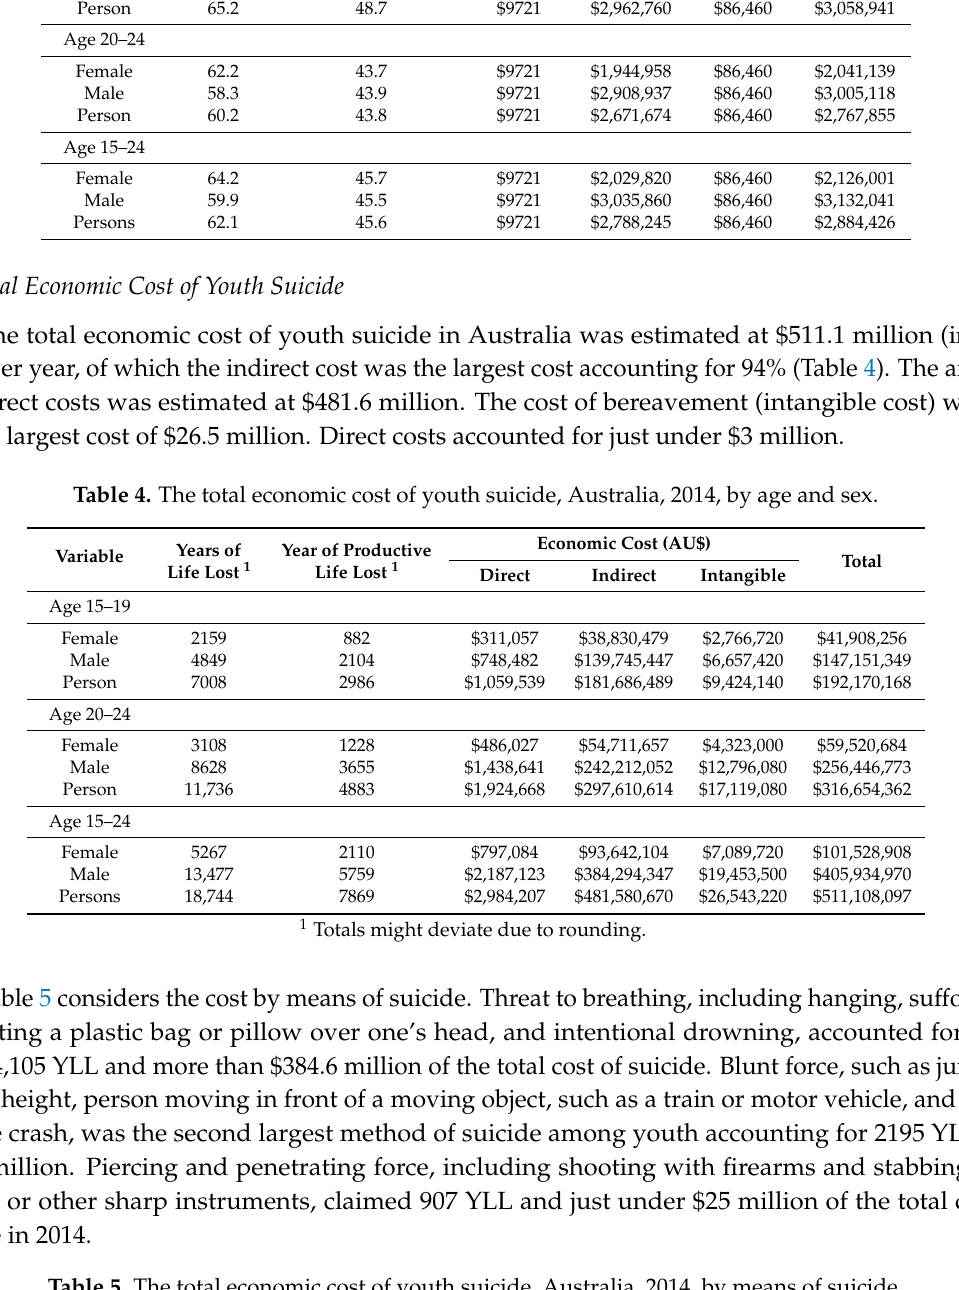
Table 5. The total economic cost of youth suicide, Australia, 2014, by means of